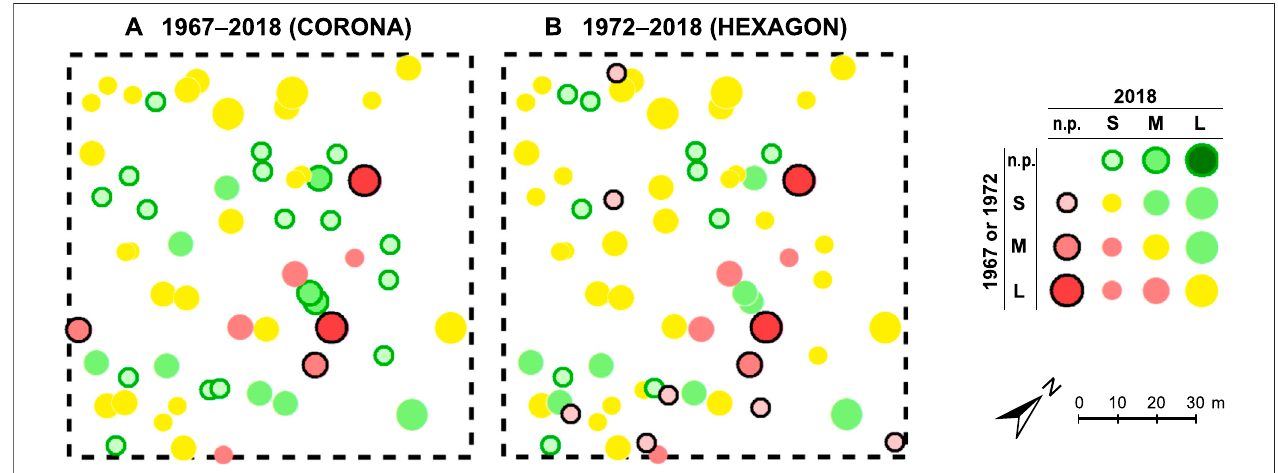
FIGURE 7 | Change maps for argan trees at test site MAO1n (A) between 1967 and 2018 and (B) 1972 – 2018, based on the FB 1967, FB 1972 and FB 2018 datasets(locationis9 ° 07 ′ 51 ″ W,30 ° 04 ′ 09 ″ N).Symbolcoloursindicatesizechangessince1967or1972(green:crown-sizeincreaseandnewtrees,yellow:unchanged, red: crown-size decrease and lost trees). Symbol outlines indicate new (green outline) and lost trees (black outline). Symbol sizes vary by tree size in 2018 (for prevailing trees). n. p. = not present, S = < 3 m, M = 3 – 7 m, L = > 7 m diameter. Note that the differences between (A) and (B) are caused by the poorer resolution of the CORONA imagery rather than actual change of the slow-growing argan trees between 1967 and